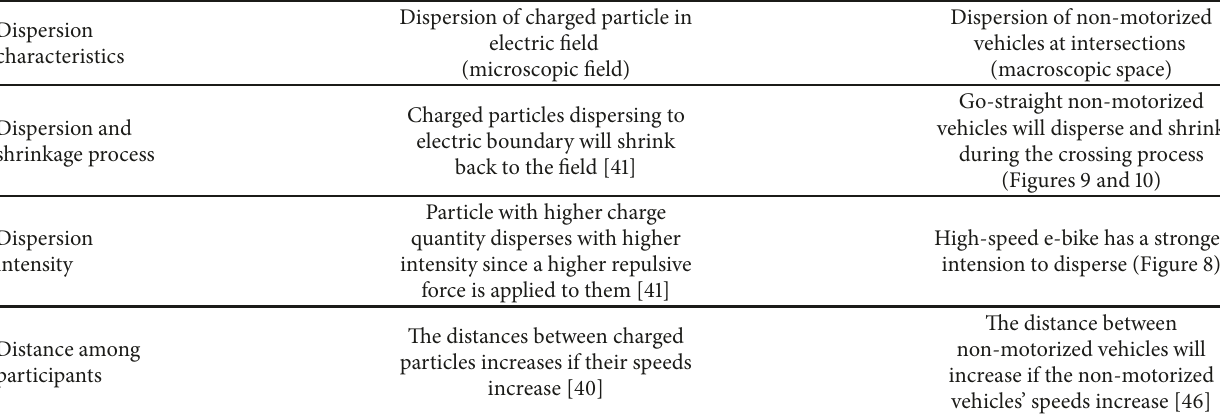
Table 3: Similarities between the dispersion of charged particles in electric fields and nonmotorized vehicles’ dispersion at intersections. Dispersion